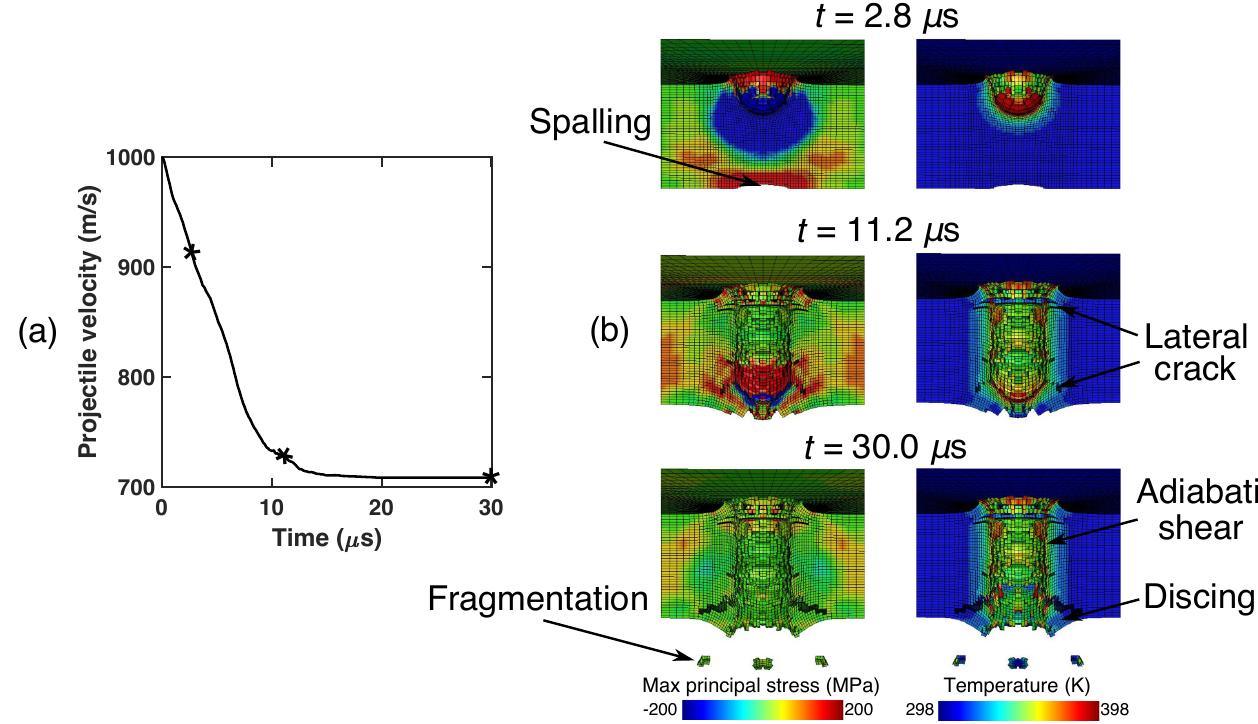
Figure 3. Normal impact of the AZ31B Mg plate with the initial velocity of 1000 m/s. ( a ) Time history of the projectile velocity. ( b ) Middle cross-section of the impact region. In Subfigure ( a ), the asterisks highlight the three time instances shown in Subfigure ( b ). In Subfigure ( b ), the projectile is removed for the sake of